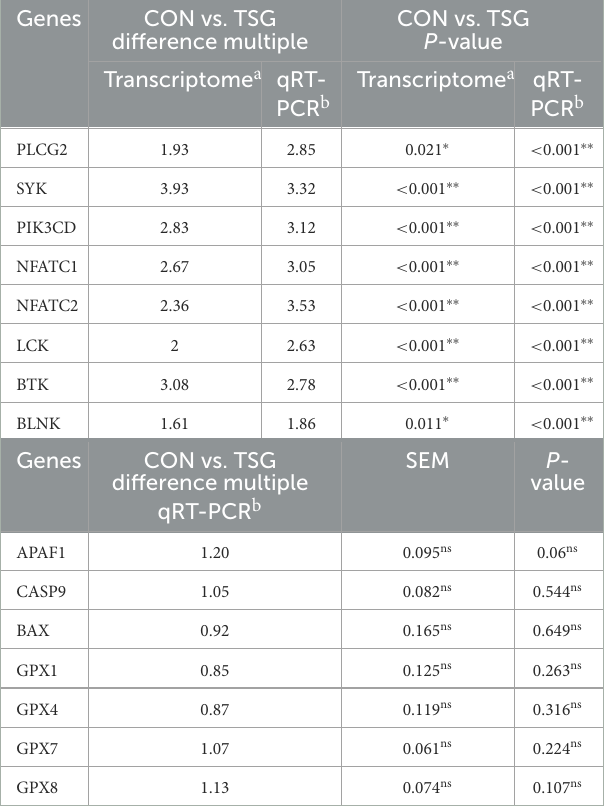
TABLE 4 Validation of transcriptomics sequencing using